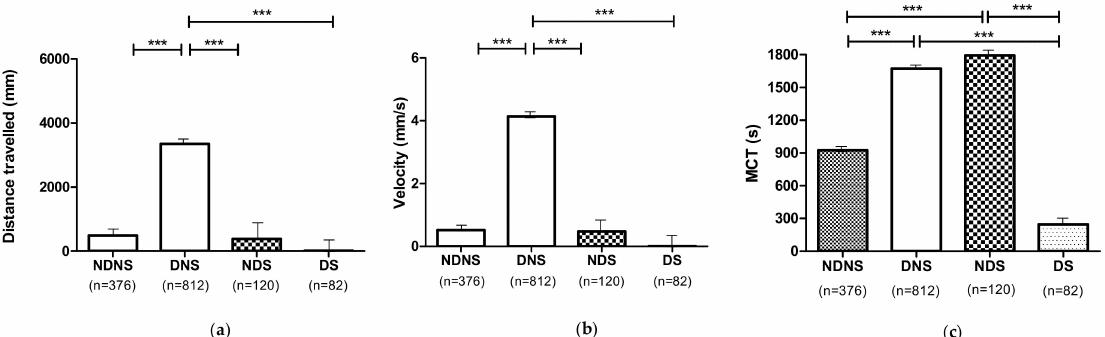
Figure 5. Locomotor performances of the 4 treatments obtained by combining non-dechorionated and dechorionated embryos with sonicated and non-sonicated 1,3-1,6 β -glucans (NDNS, DNS, NDS and DS); all larvae, untreated (0 mg L − 1 ) and treated at 2, 4 and 8 mg L − 1 of 1,3-1,6 β -glucans, were used. ( a ) Distance travelled; ( b ) Velocity; ( c ) MCT. Data are given as mean and standard error. (*** p ≤ 0.001).